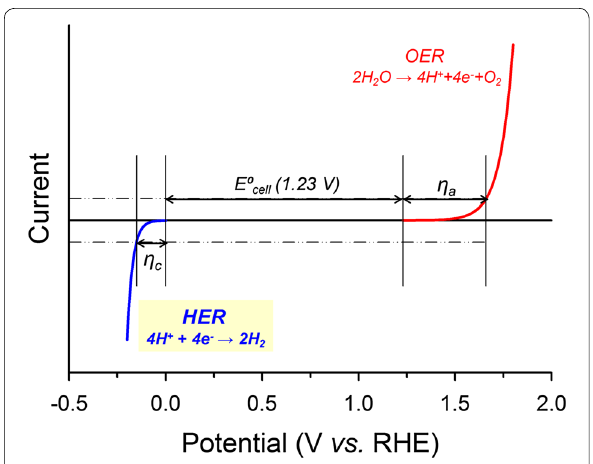
Fig. 1 I - V curve for the full water splitting